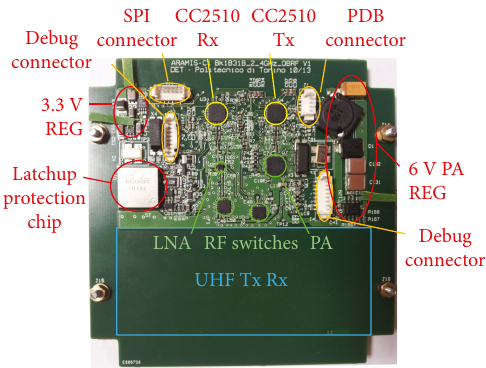
Figure 8: Photograph of CubeTCT.